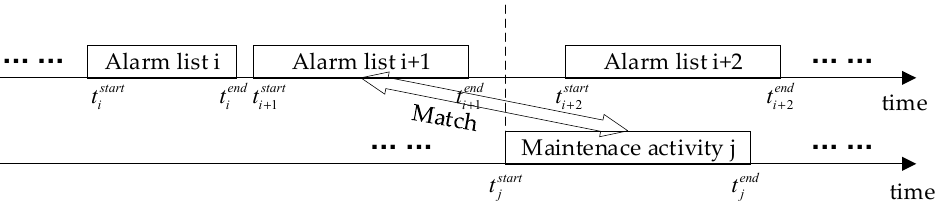
Figure 2. The match criterion of alarm lists and maintenance records.